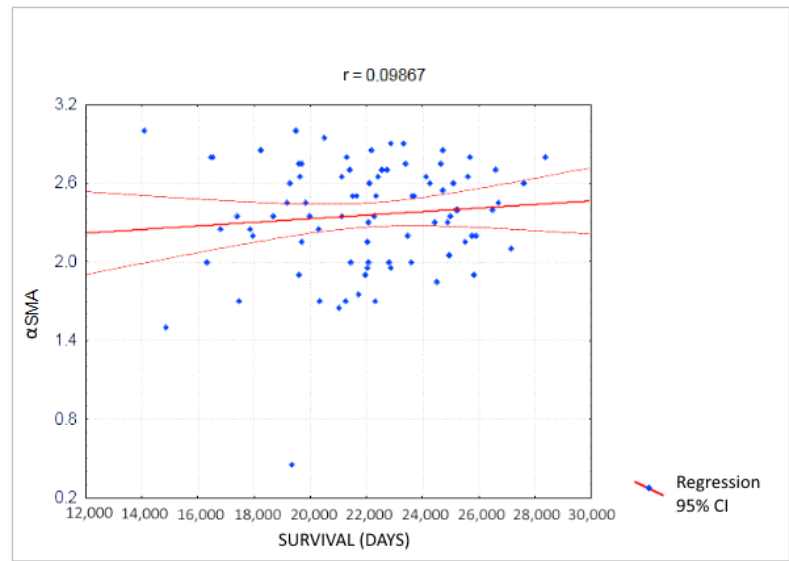
Figure 7. Correlation between the expression of the α SMA protein and the survival time in pan- creatic ductal adenocarcinoma